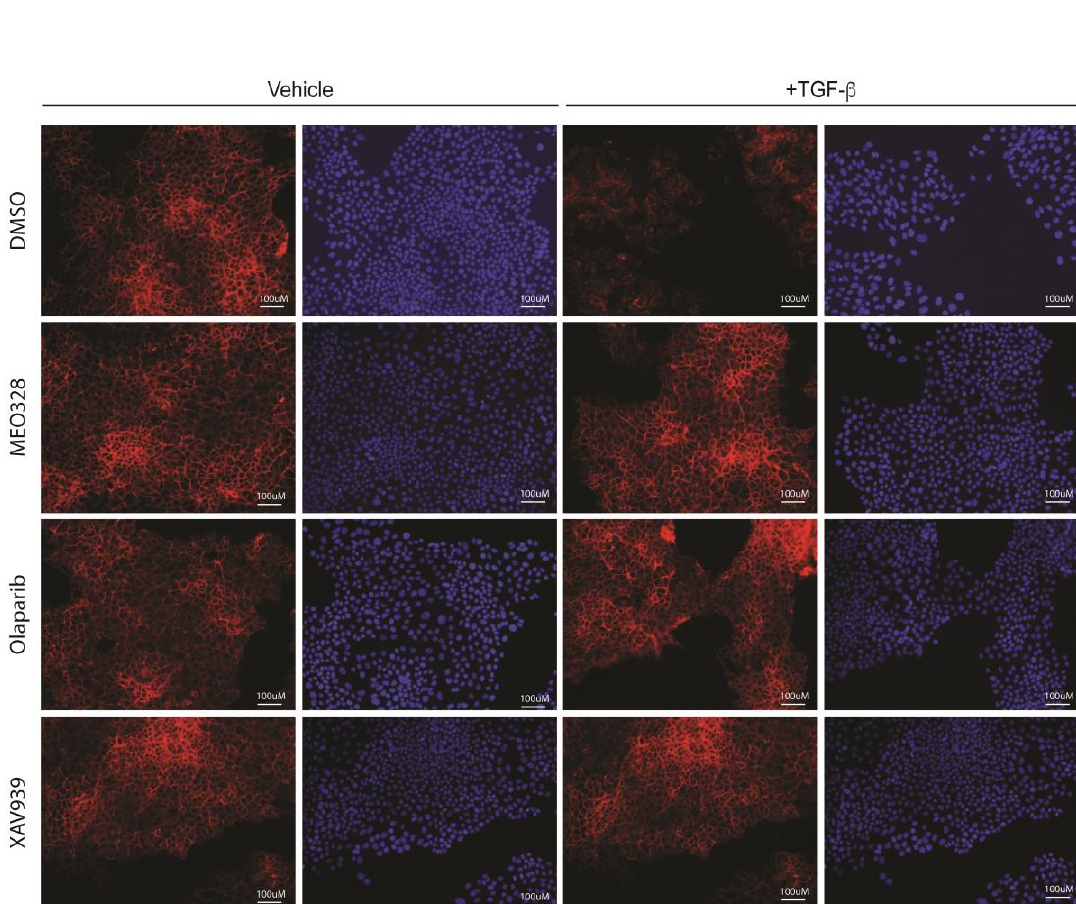
Figure A2. Cells were treated as per schedule at the top of the figure, and imaged for E-cadherin Figure A2. (red) and nuclei (DAPI). The DAPI images show no significant loss of cell numbers (viability and toxicity) relative to untreated cells in the presence of the PARP inhibitors. Images were taken with 20x